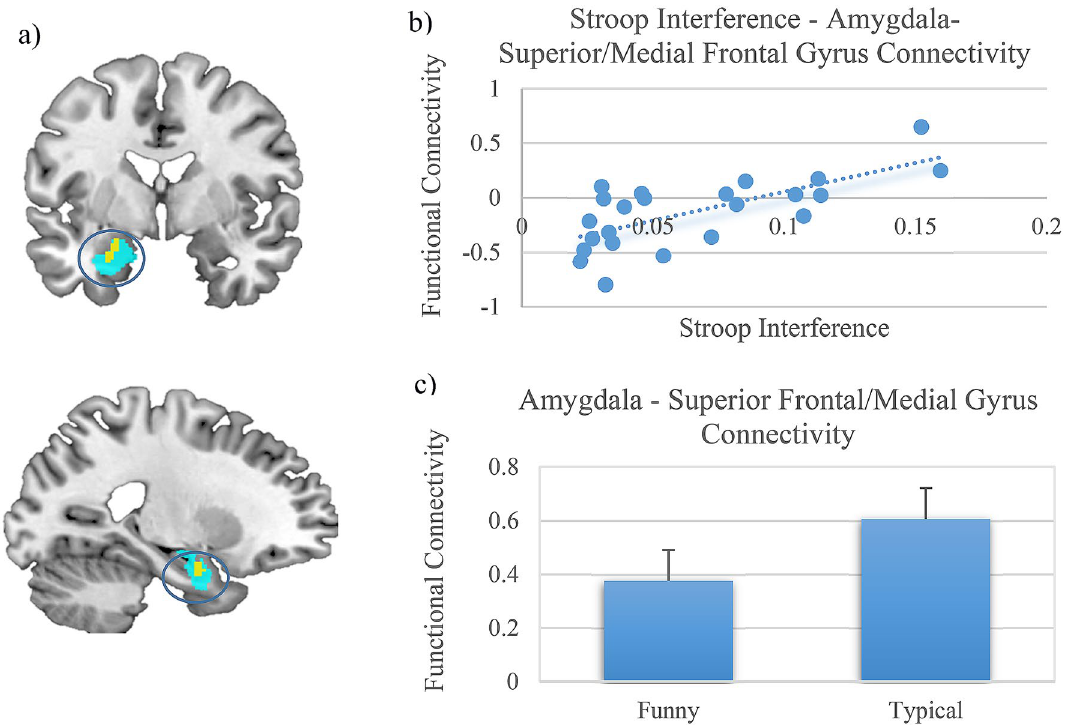
Figure 3. Functional connectivity: covariate analysis (stroop interference): ( a ) significant functional connectivity between the right superior frontal/medial gyrus and the left amygdala (turquoise anatomically defined region-of-interest, yellow significantly activated amygdala (SMV-corrected)). ( b,c ) Parameter Estimates were extracted from the significant functional amygdala cluster, the error bars represent SEM.